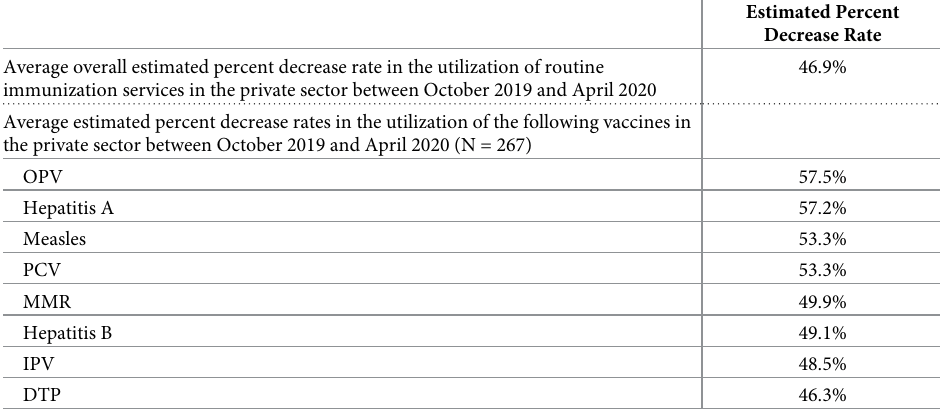
Table 2. Percent decrease rate in the utilization of routine vaccination in the private sector between October 2019 and April 2020.